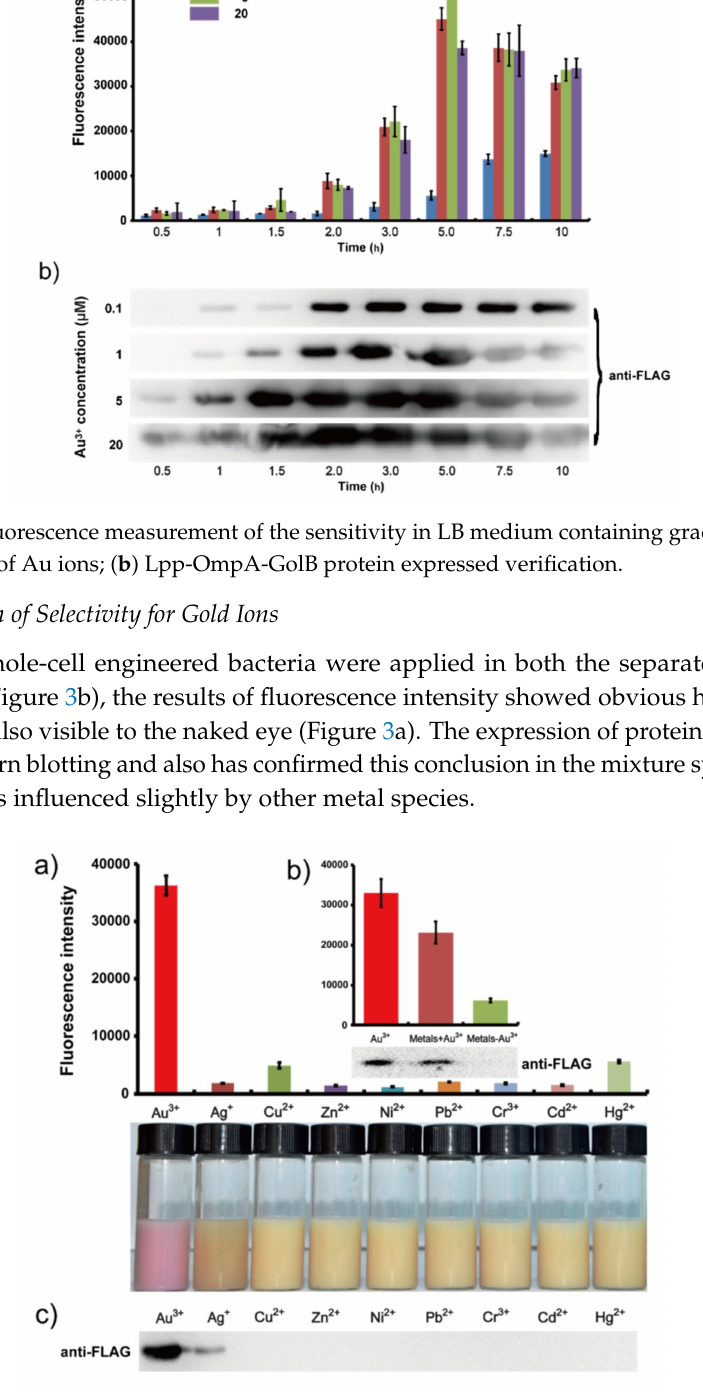
Figure 3. ( a ) Fluorescence measurement of E. coli cells containing the gold-induced plasmid expressed by recombined proteins with concentrations of 10 µ M of metal ions and a photograph of the corresponding fluorescence. ( b ) Fluorescence measurement of the selectivity to mixed metal ions (Au 3+ , Ag + , Cu 2+ , Zn 2+ , Ni 2+ , Cd 2+ , Cr 3+ , Hg 2+ or Pb 2+ ). ( c ) Lpp-OmpA-GolB fusion protein expressed verification by Western blotting using anti-FLAG antibody. The first lane is the Au 3+ induction case. Figure 3a,c, consistent on the each of the upper and lower